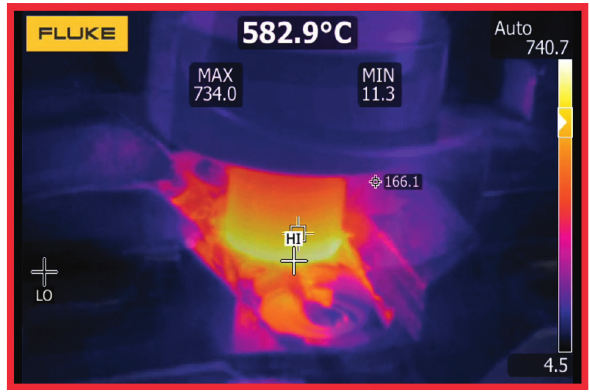
Figure 4: Thermal image of the stir zone during surface processing of CuNi with a reinforcement of B 4 C particle at